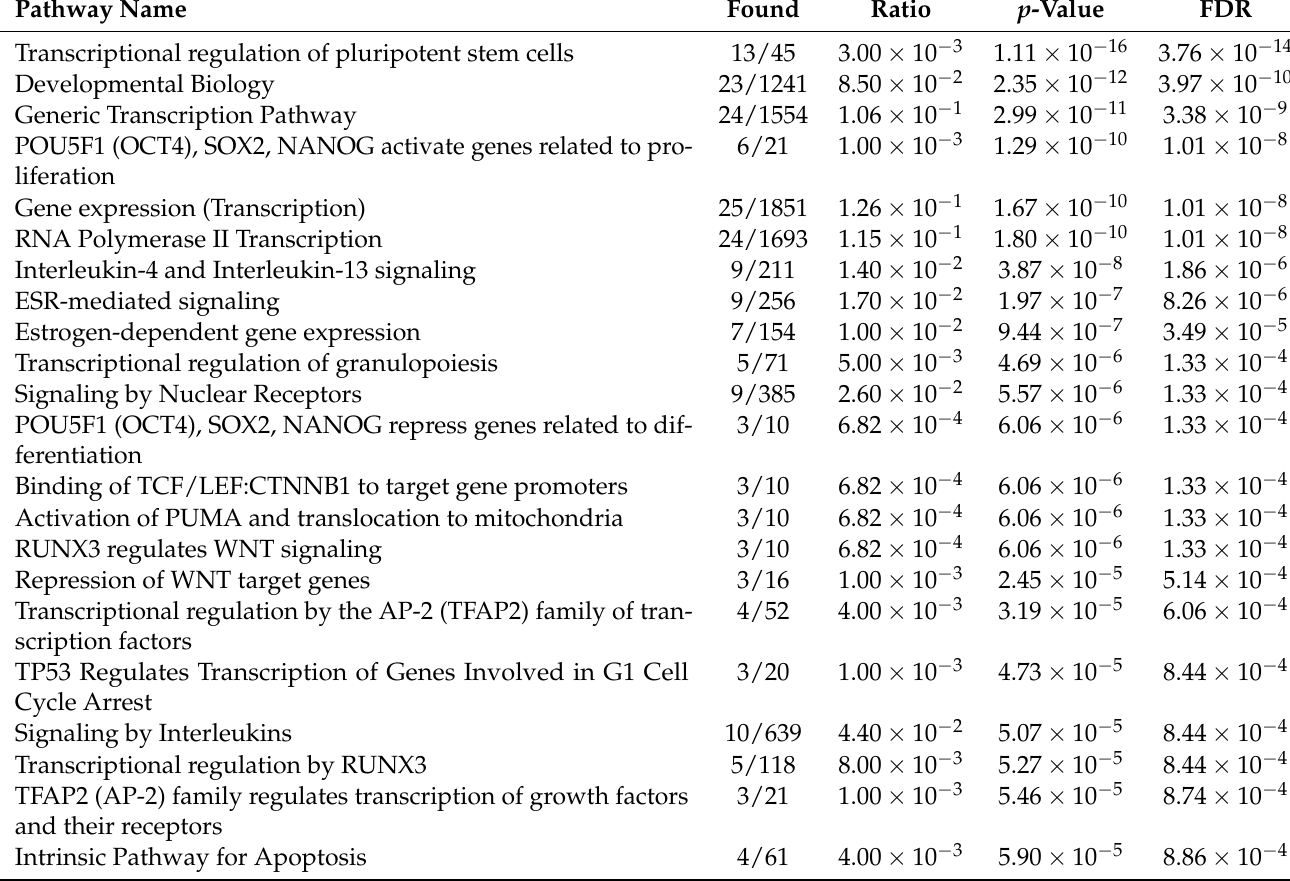
Table 6. REACTOME enrichment analysis for 27 TFs in Table